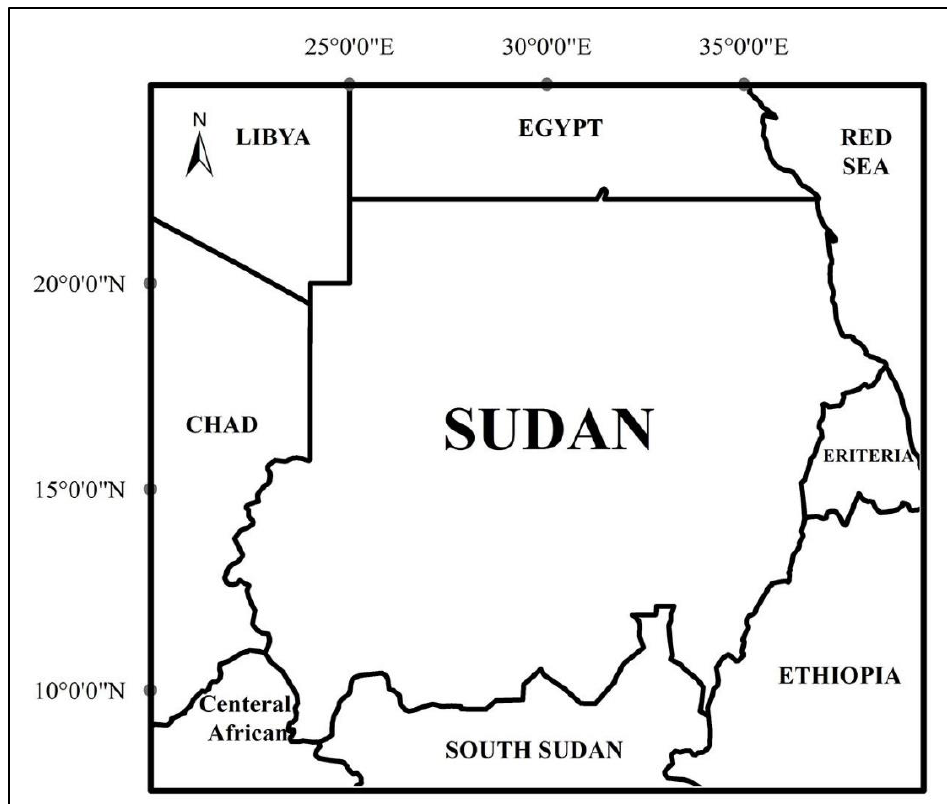
Figure 1. Location of the study area, Sudan.